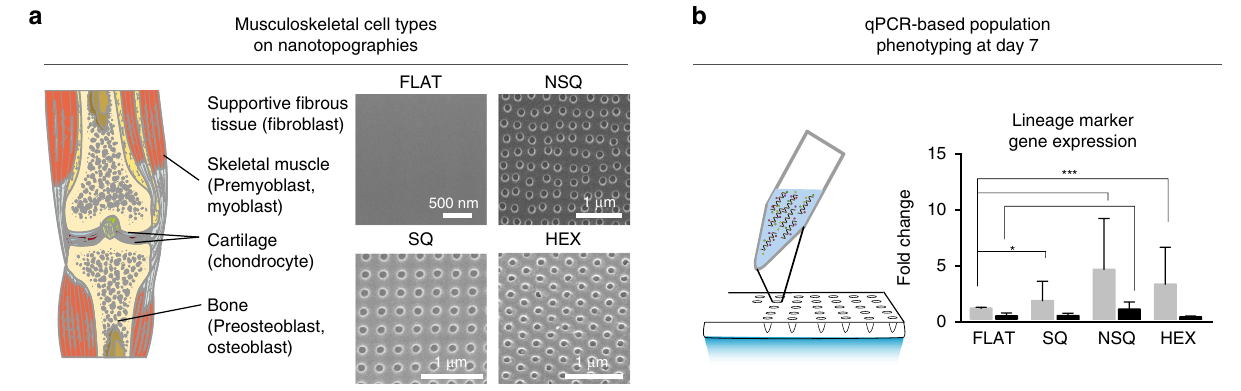
( RUNX2 , SP7 ) and late ( BGLAP , SPP1 ) osteogenic markers when cultured on NSQ relative to FLAT (Fig. 3d – g), in line with pre- vious studies 7 – 9 . The gene expression pro fi le of both pre- osteoblasts and osteoblasts on NSQ resembled cells osteogeni- cally differentiated after 4 days (see Supplementary Fig. 6b, f). Chondrocytes cultured on HEX showed increased expression of